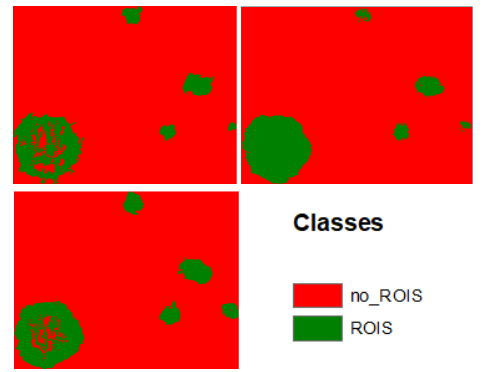
Figure 5 Classified images using the ISODATA unsupervised classification. Top left: 16/04, Top Right: 17/04, Bottom left: 18/04.